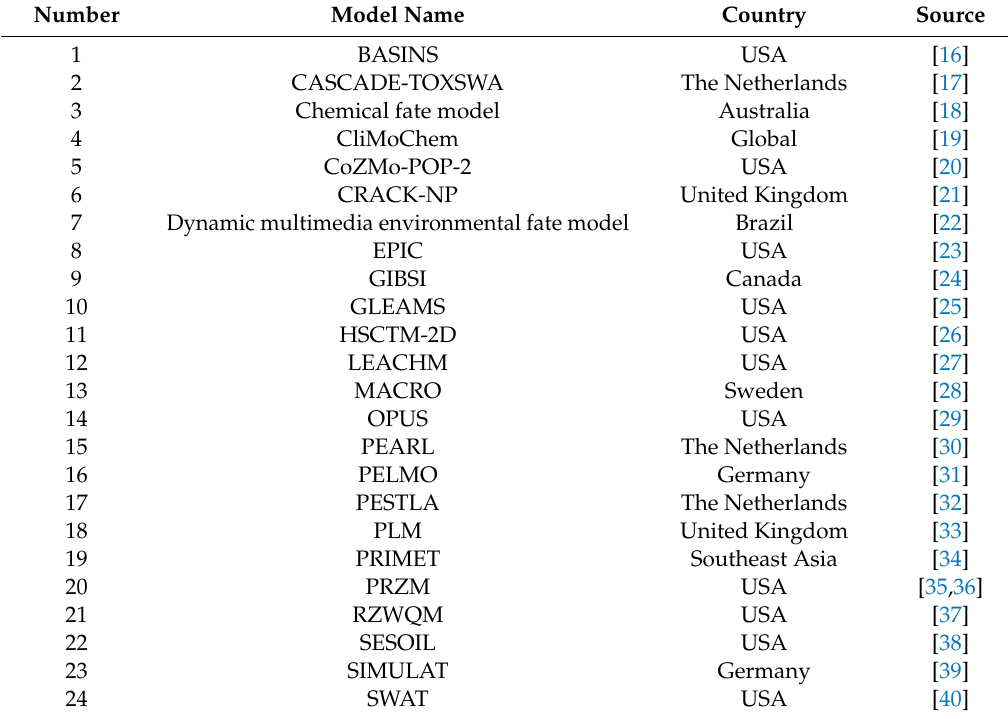
Table 1. The pesticide fate models that are identified for this